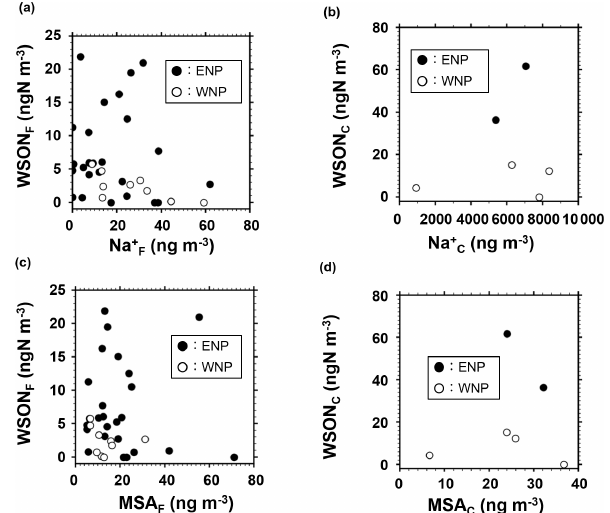
Figure 4. Concentrations of WSON as functions of those of sodium (a, b) and MSA (c, d) , where (a) and (c) are for the fine particles and (b) and (d) are for the coarse particles. Solid and open circles represent the data of the eastern North Pacific (ENP) and western North Pacific (WNP),